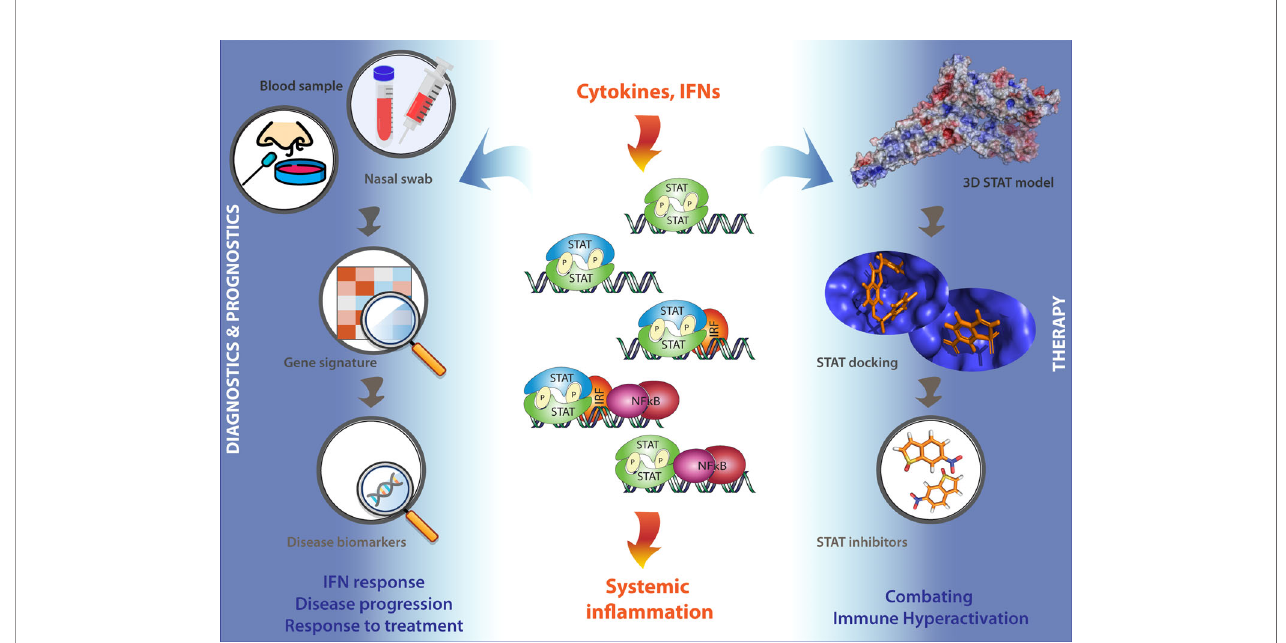
FIGURE 4 | STATs as potential therapeutic targets in COVID-19 patients. Under conditions of excessive in fl ammation, maximum expression of many pro- in fl ammatory cytokine and IFN-stimulated genes has shown to depend on combinatorial actions of transcription factors of the STAT, IRF, and NF-kB families. This identi fi es STATs as potential therapeutic targets in severe COVID-19. Thus, a STAT-dependent pro-in fl ammatory gene signature could serve as a novel diagnostic tool to monitor and diagnose IFN responses, disease progression, and responses to treatment using blood or nasal swabs from COVID-19 patients (Left). On the other hand, the further testing and optimizing of already available Statinhibs, together with the identi fi cation of new Statinhibs using in silico 3D STAT modeling, virtual docking and screening, and in vitro validation, may offer new clinical bene fi ts in combating immune hyper-activation during severe COVID-19